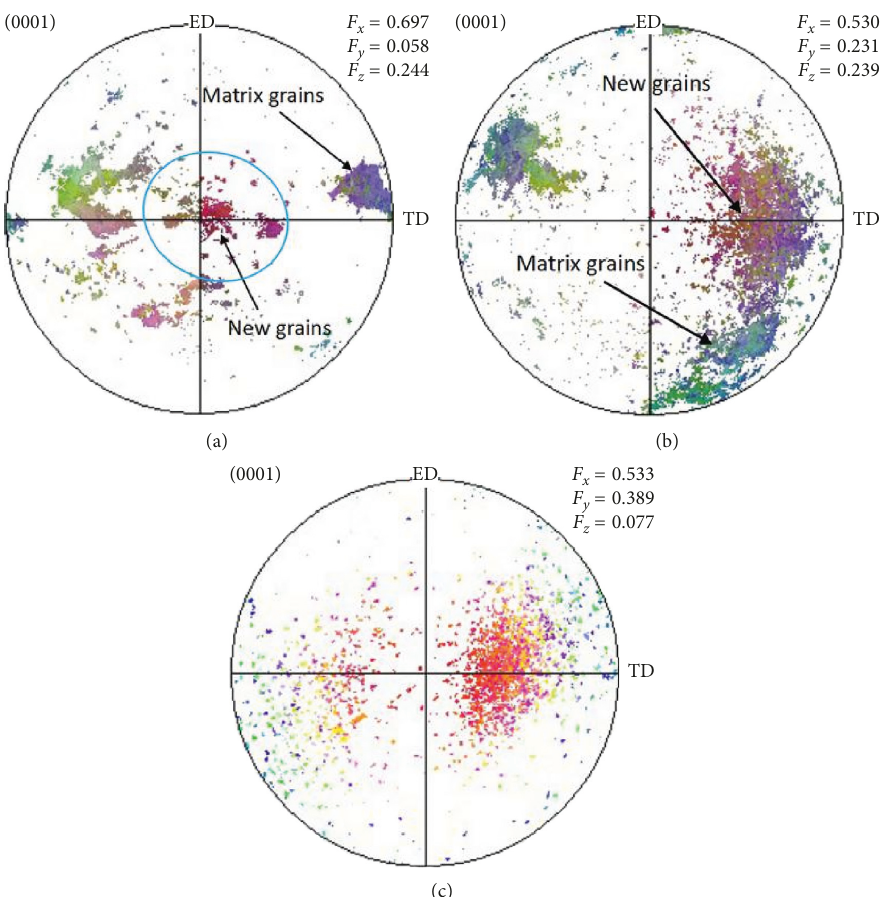
Figure 8: {0001} pole figure of the samples after CEE process: (a) one-pass; (b) two-pass; (c) three-pass.